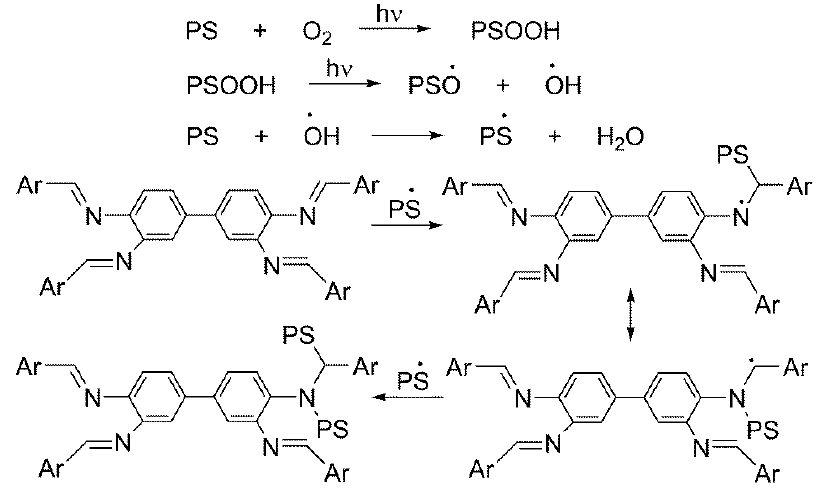
Figure 5. Photostabilization of PS in the presence of Schiff bases 1 – 3 .